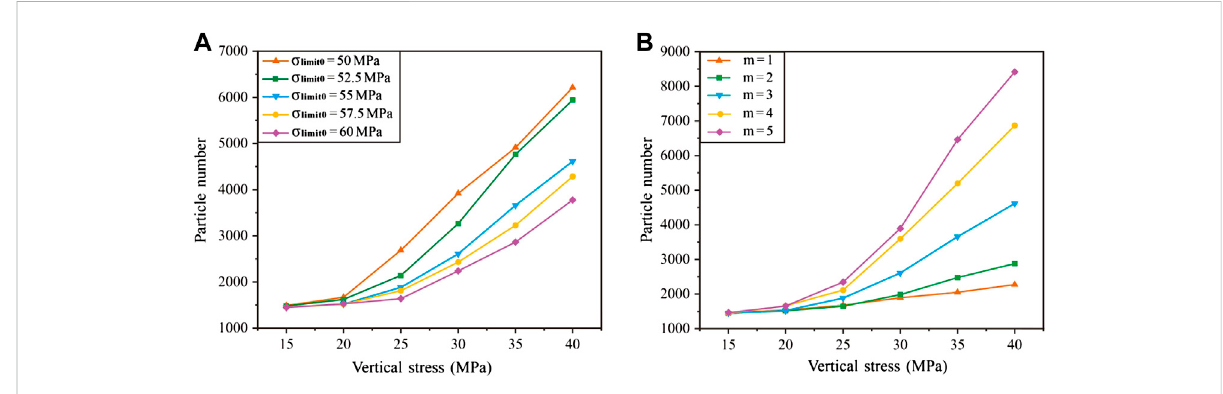
FIGURE 4 Evolution characteristics of particle number: (A) Group A and (B) Group